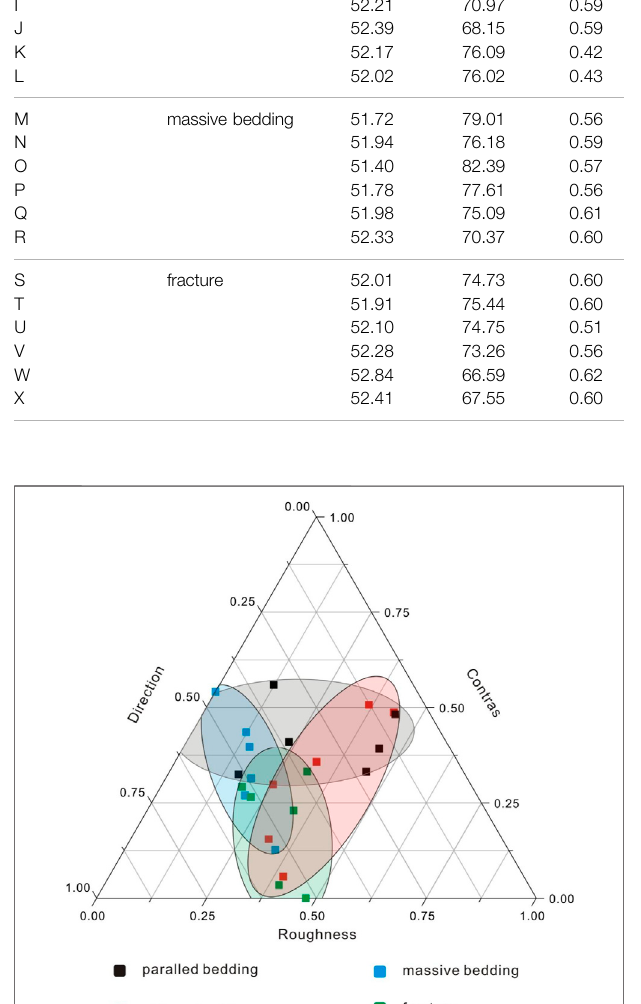
oblique bedding